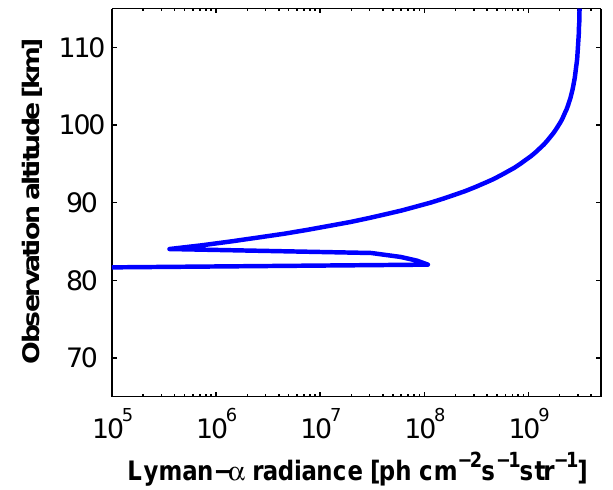
Fig. 7. Simulation of the radiance detected from the geocorona and an NLC for a rocket-borne Lyman- α detector viewing horizontally. The NLC was modelled as a cloud of thickness 2km with 100cm − 3 particles of radius